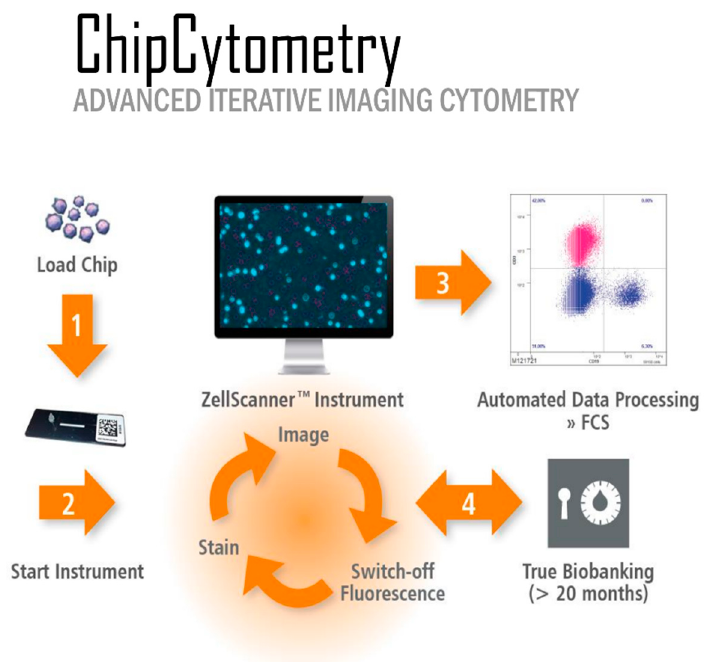
Figure A2. Workflow of Chipcytometry. Cells or tissue samples are loaded onto ZellSafe TM chips (1) and fixed. After starting the process (2), repetitive cycles of staining up to five markers and photobleaching afterwards generates multiplex data that can be analyzed via the ZellExplorer Software and exported as Flow Cytometry Standard files (3). Furthermore, storage times of more than 20 months enable biobanking (4) and reanalysis if necessary or wanted